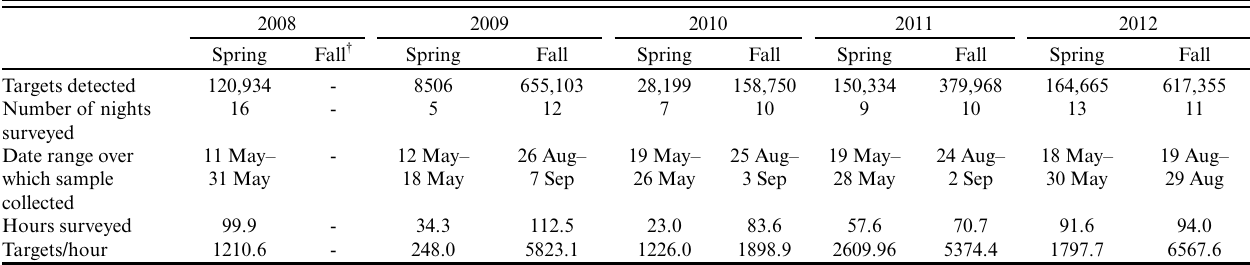
Table 1 . The total numbers of tracked avian targets detected by the horizontal radar, by season and year, across the survey period from 2008 to 2012 at the Dokie I Wind Energy Project in northeast British Columbia. Variation in the number of nights surveyed between season and years reflected both problems encountered with weather and equipment. Target numbers shown reflect exclusion of nonavian targets through application of filter expressions in